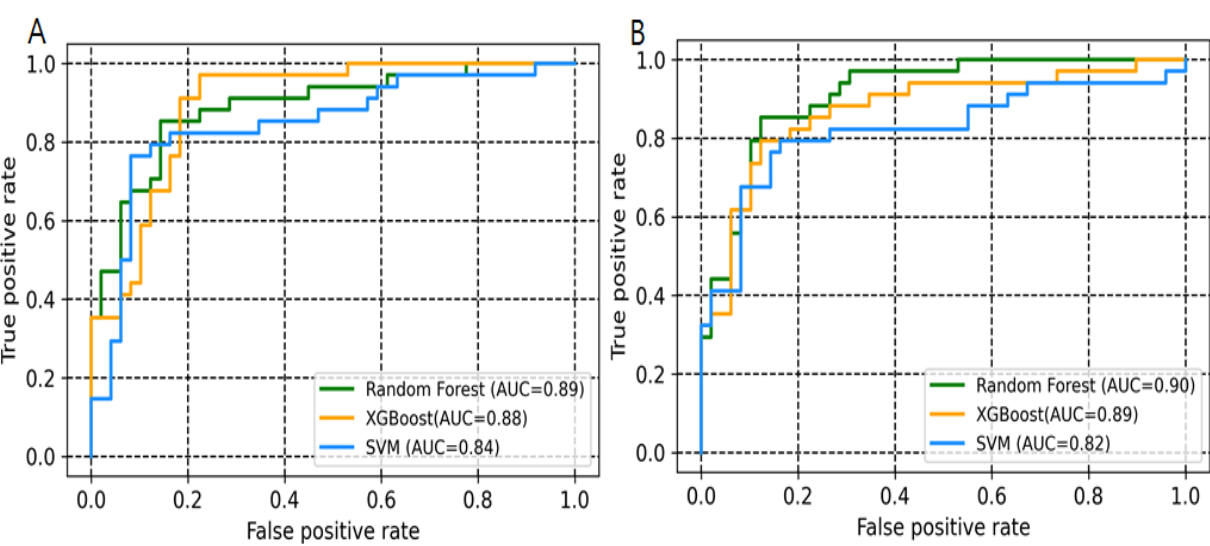
Figure 2. ROC curve showing the performance of binary class models. ( A ) All descriptor set. ( B ) Selected descriptors set (Boruta method).